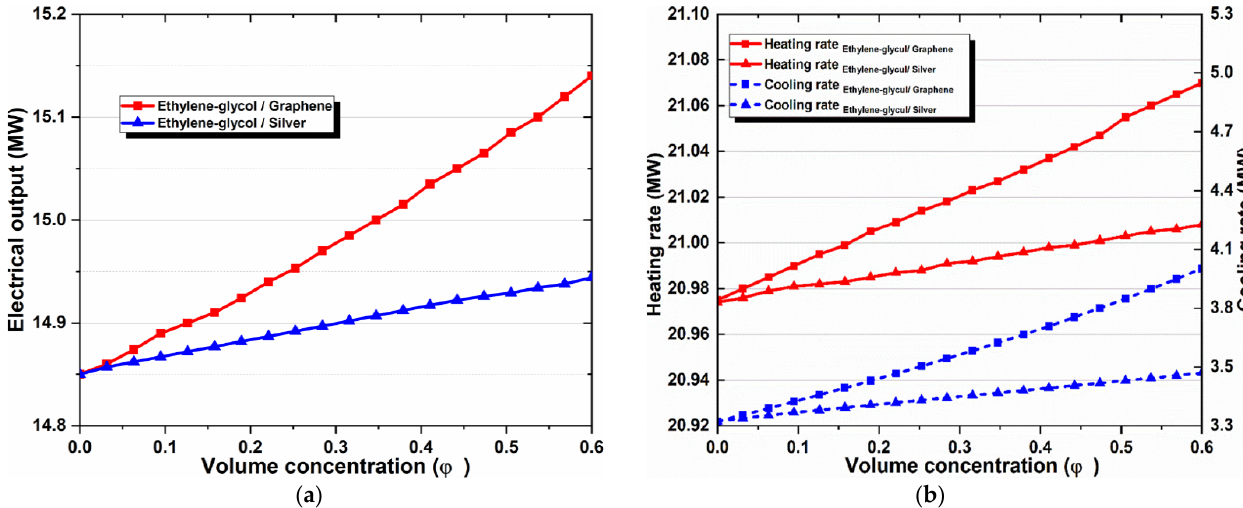
Figure 6. Effect of nanoparticle volume concentration on the outlet temperature of CPC.